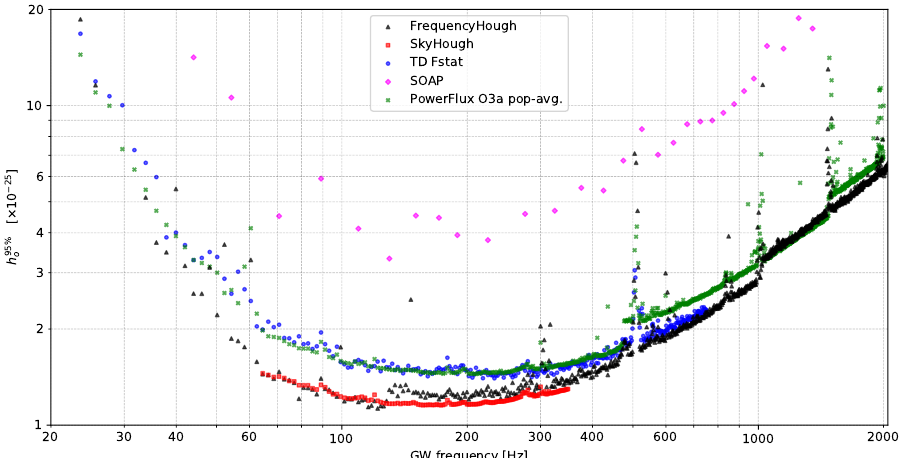
Figure 5. Comparison of 95% confidence upper limits on GW amplitude obtained in the O3 all-sky search by the FrequencyHough pipeline (black triangles), the SkyHough pipeline (red squares), the Time-Domain F-statistic pipeline (blue circles), and the SOAP pipeline (magenta diamonds). Population-averaged upper limits obtained in the Powerflux O3a search are marked with dark-green crosses. Figure taken from